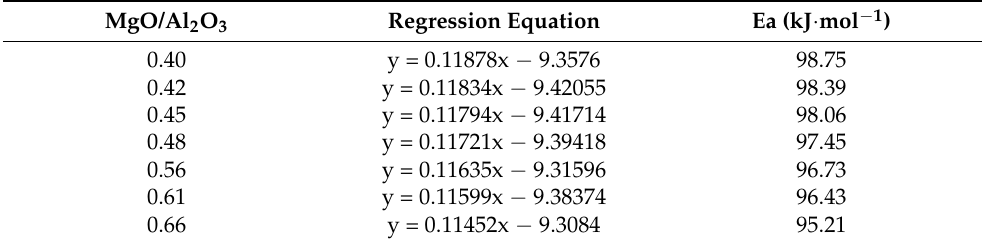
Figure 5. Variation of Ln η and 1/T with MgO/Al 2 O 3 ratio. Table 4. The calculated apparent activation energy of different slags.